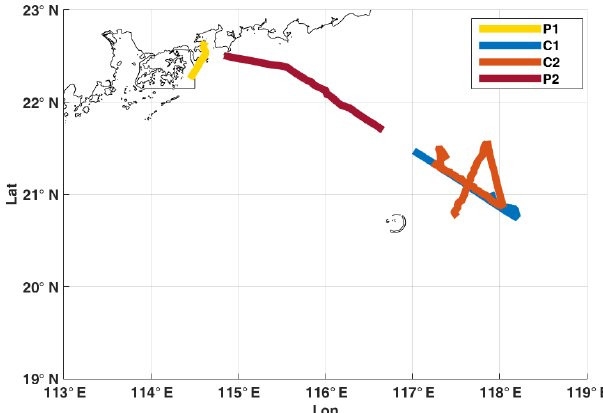
Figure 6. The ship track during the P1, C1, C2, and P2